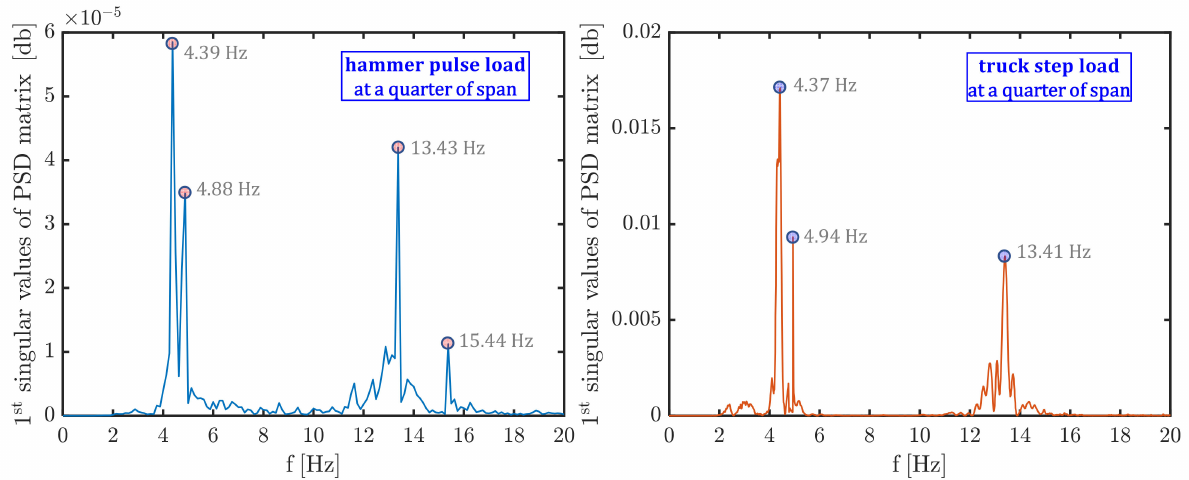
Figure 8. Identification of natural frequencies based on peak picking from the first singular values of the PSD